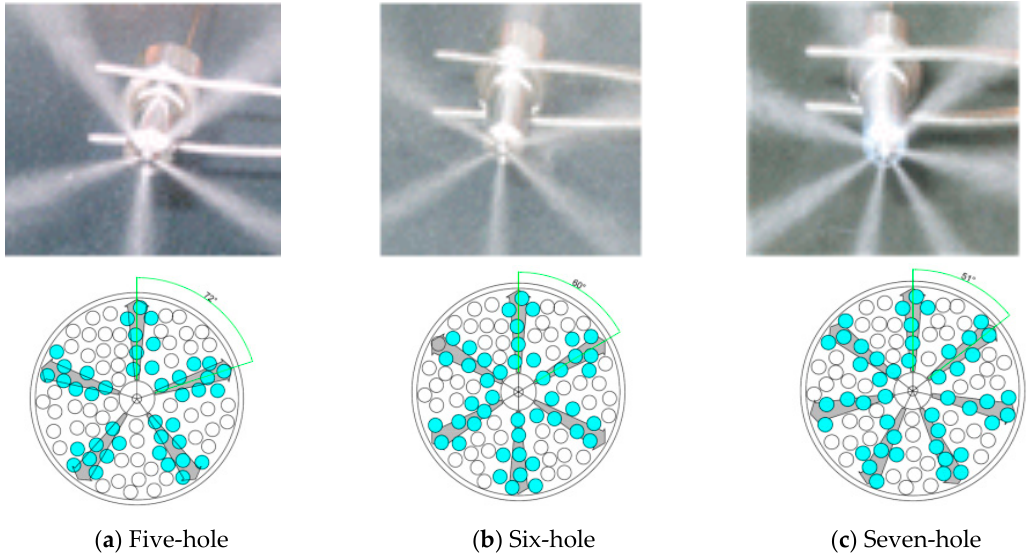
Table 4. Test conditions (Coolant temperature: 82 ± 2 °C).